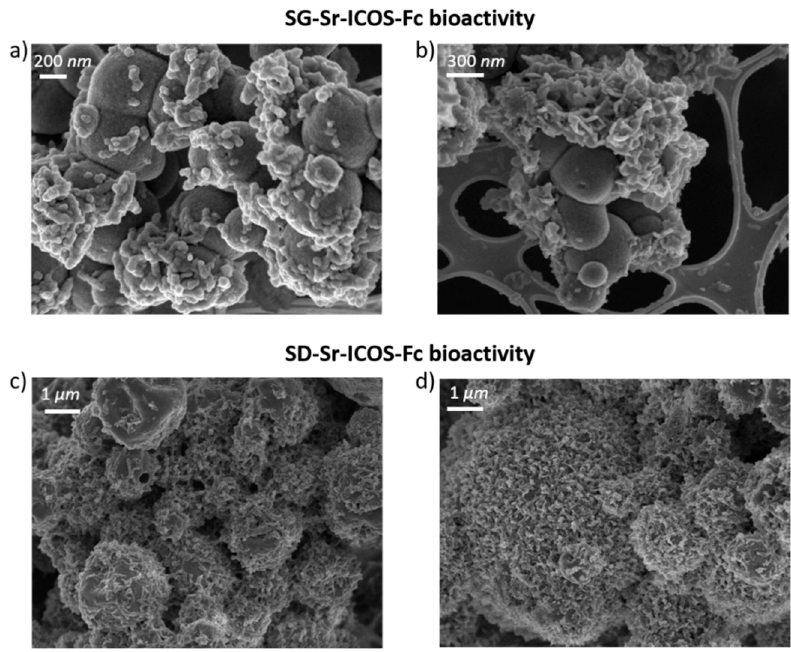
Figure 6. FESEM images of SG-Sr-ICOS-Fc bioactivity after 1 day ( a ) and 7 days ( b ) of soaking in SBF, SD-Sr-ICOS-Fc after 1 day ( c ) and 7 days ( d ) of soaking in SBF.